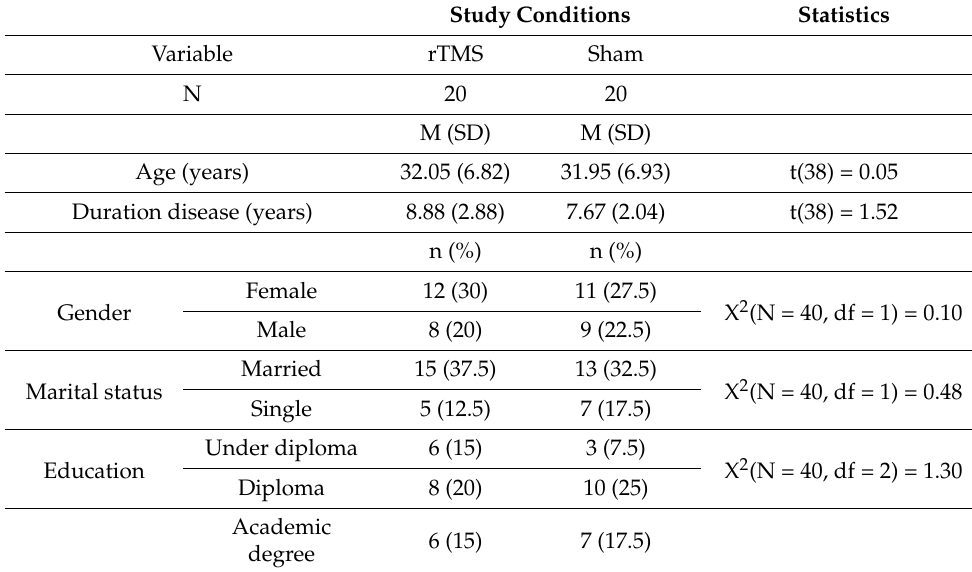
Table 1. Sociodemographic information of participants in the rTMS and sham condition.